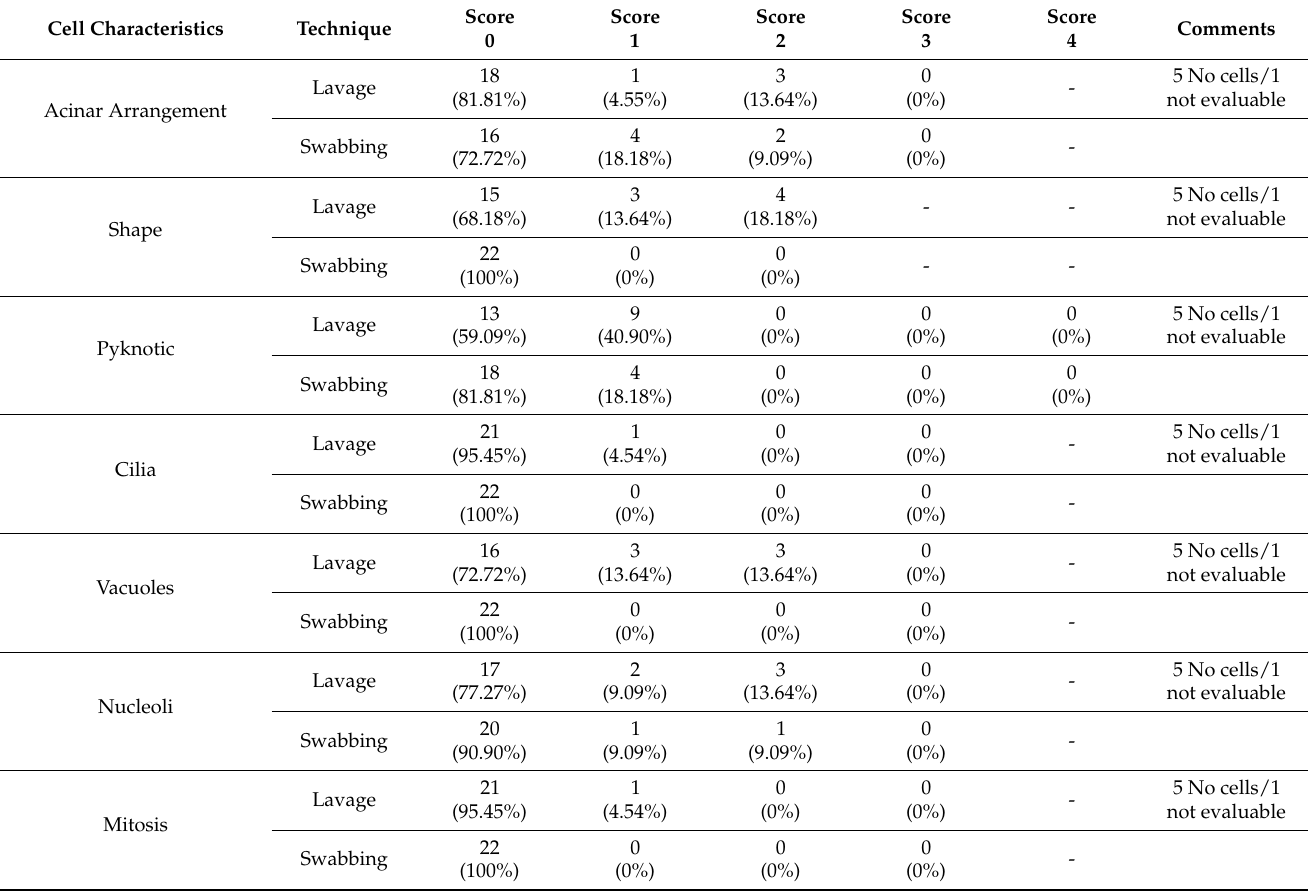
Table 6. Grading and distribution of the cytological characteristics of the cells in samples according to uterine swabbing or the uterine lavage method. No statistically significant differences were observed for any of these